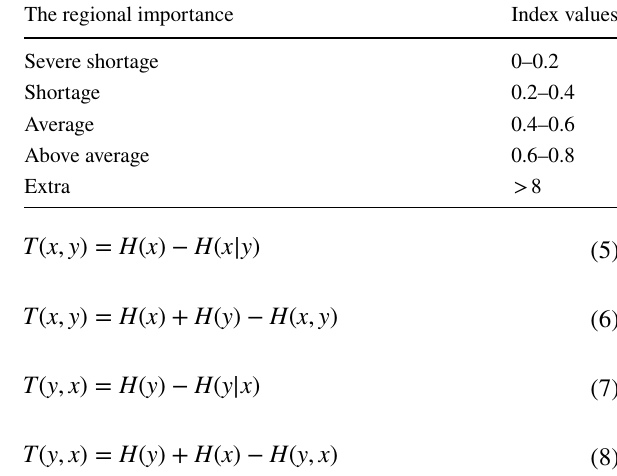
Table 2 A classification of the values of the ITI The regional